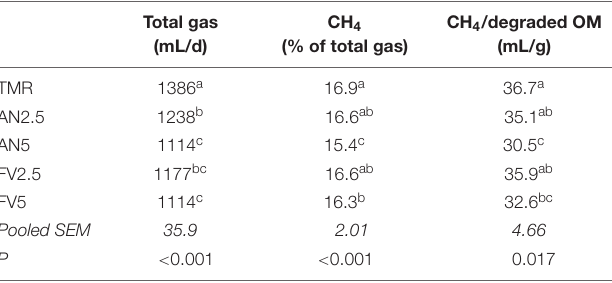
TABLE 2 | Total gas production and methane concentration of the produced gas (days 7–13) and methane production per g of degraded organic matter (OM; days 7–12) of the five treatments.